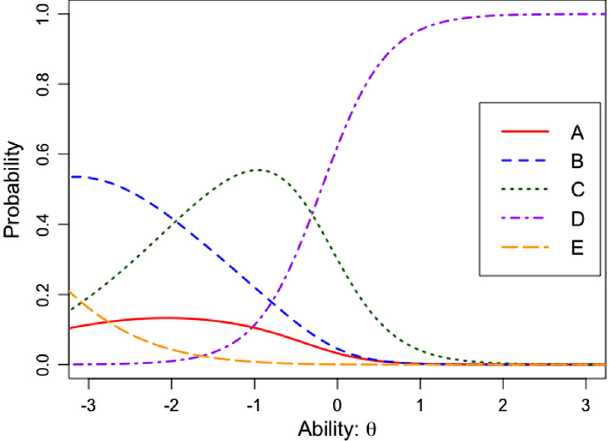
FIG. 1. Trace lines for question 13. From this plot it can be seen that option D is the correct response. The most common incorrect response is dependent on which part of ability space is being considered. The item parameters used to make this plot were taken from Table III in the Appendix. Below the figure, please find question 13 and the response options that correspond to the trace lines. FCI 13 ) A boy throws a steel ball straight up. Consider the motion of the ball only after it has left the boy ’ s hand but before it touches the ground, and assume that forces exerted by the air are negligible. For these conditions, the force(s) acting on the ball is